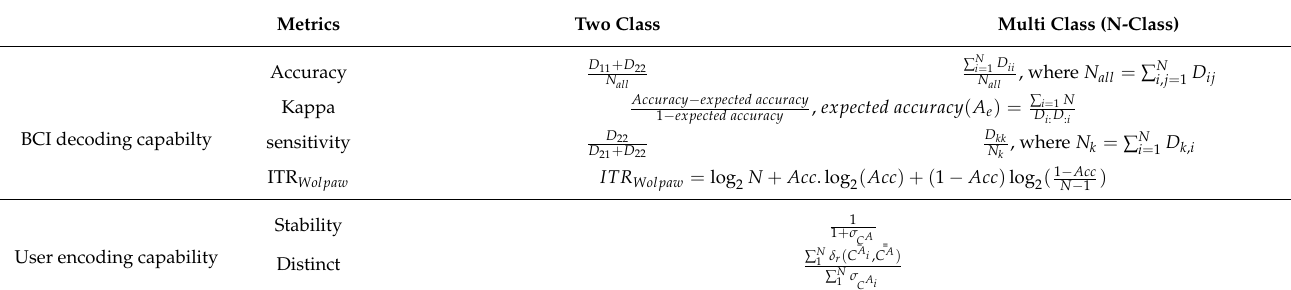
Table 4. Summary of all the